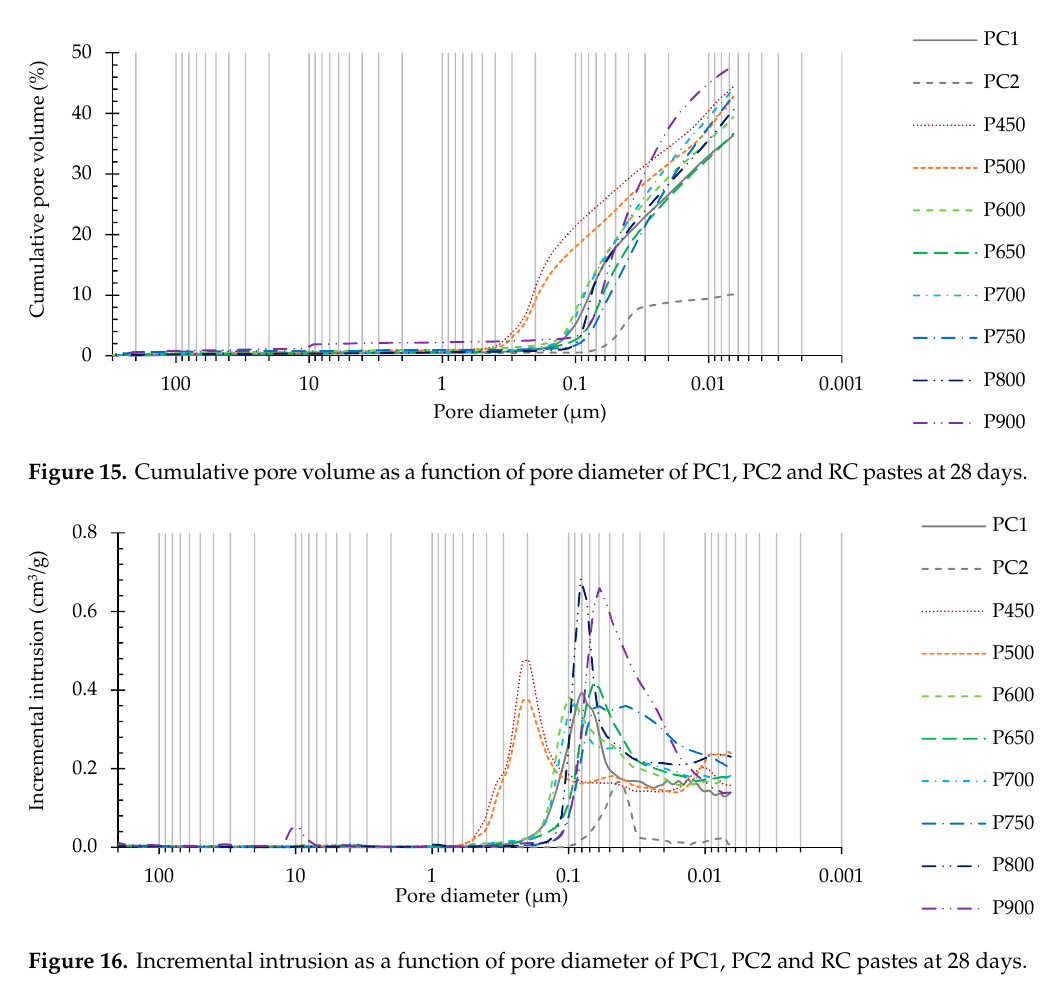
Figure 16. Incremental intrusion as a function of pore diameter of PC1, PC2 and RC pastes at 28 days. Table 7. Porosity parameters of PC1, PC2 and RC pastes.